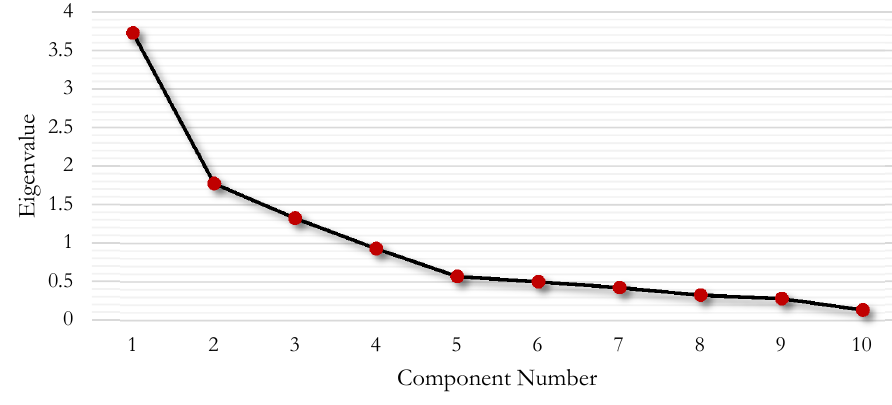
Figure 2. Scree plot for measures for curbing unethical practices of